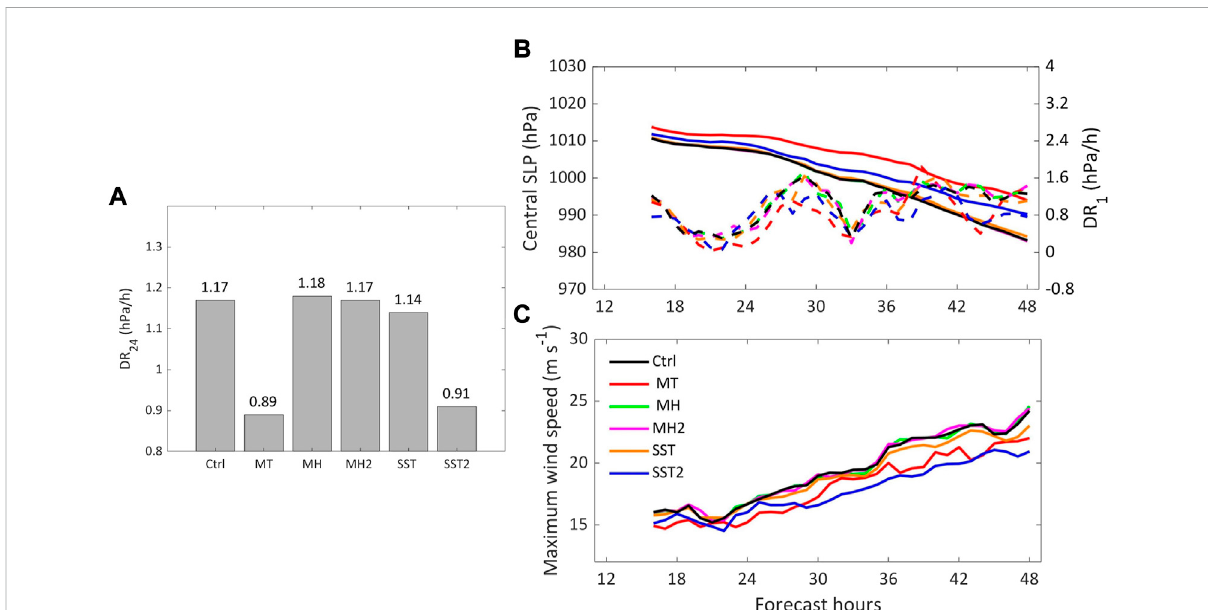
FIGURE 12 Simulated24-hdeepeningrates(duringthelast24forecasthours) (A) ,timeseriesofcyclonecentralSLPs (B) ,andmaximumwindspeeds (C) for six experiments. Solid and dashed curves in (B) represent the central SLPs and 1-h deepening rates, respectively. All variables are averaged among all the four